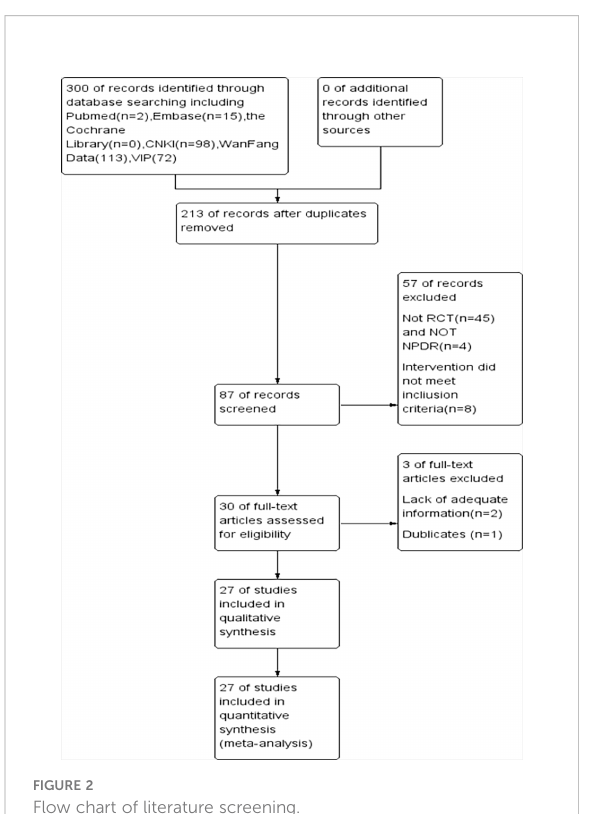
FIGURE 2 Flow chart of literature screening.